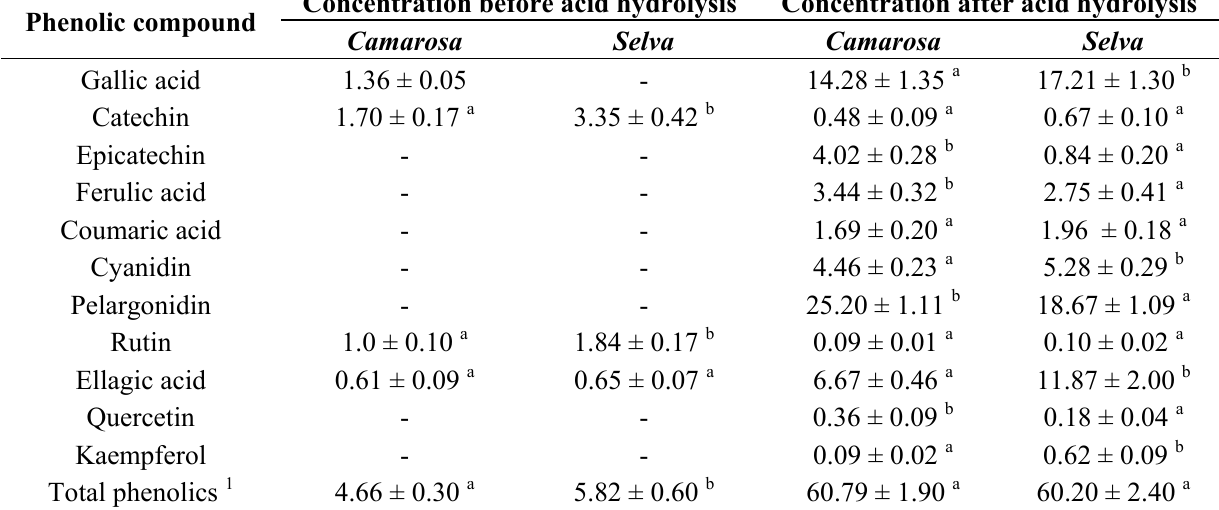
Table 2. Phenolic compounds concentration before and after acid hydrolysis in two strawberry